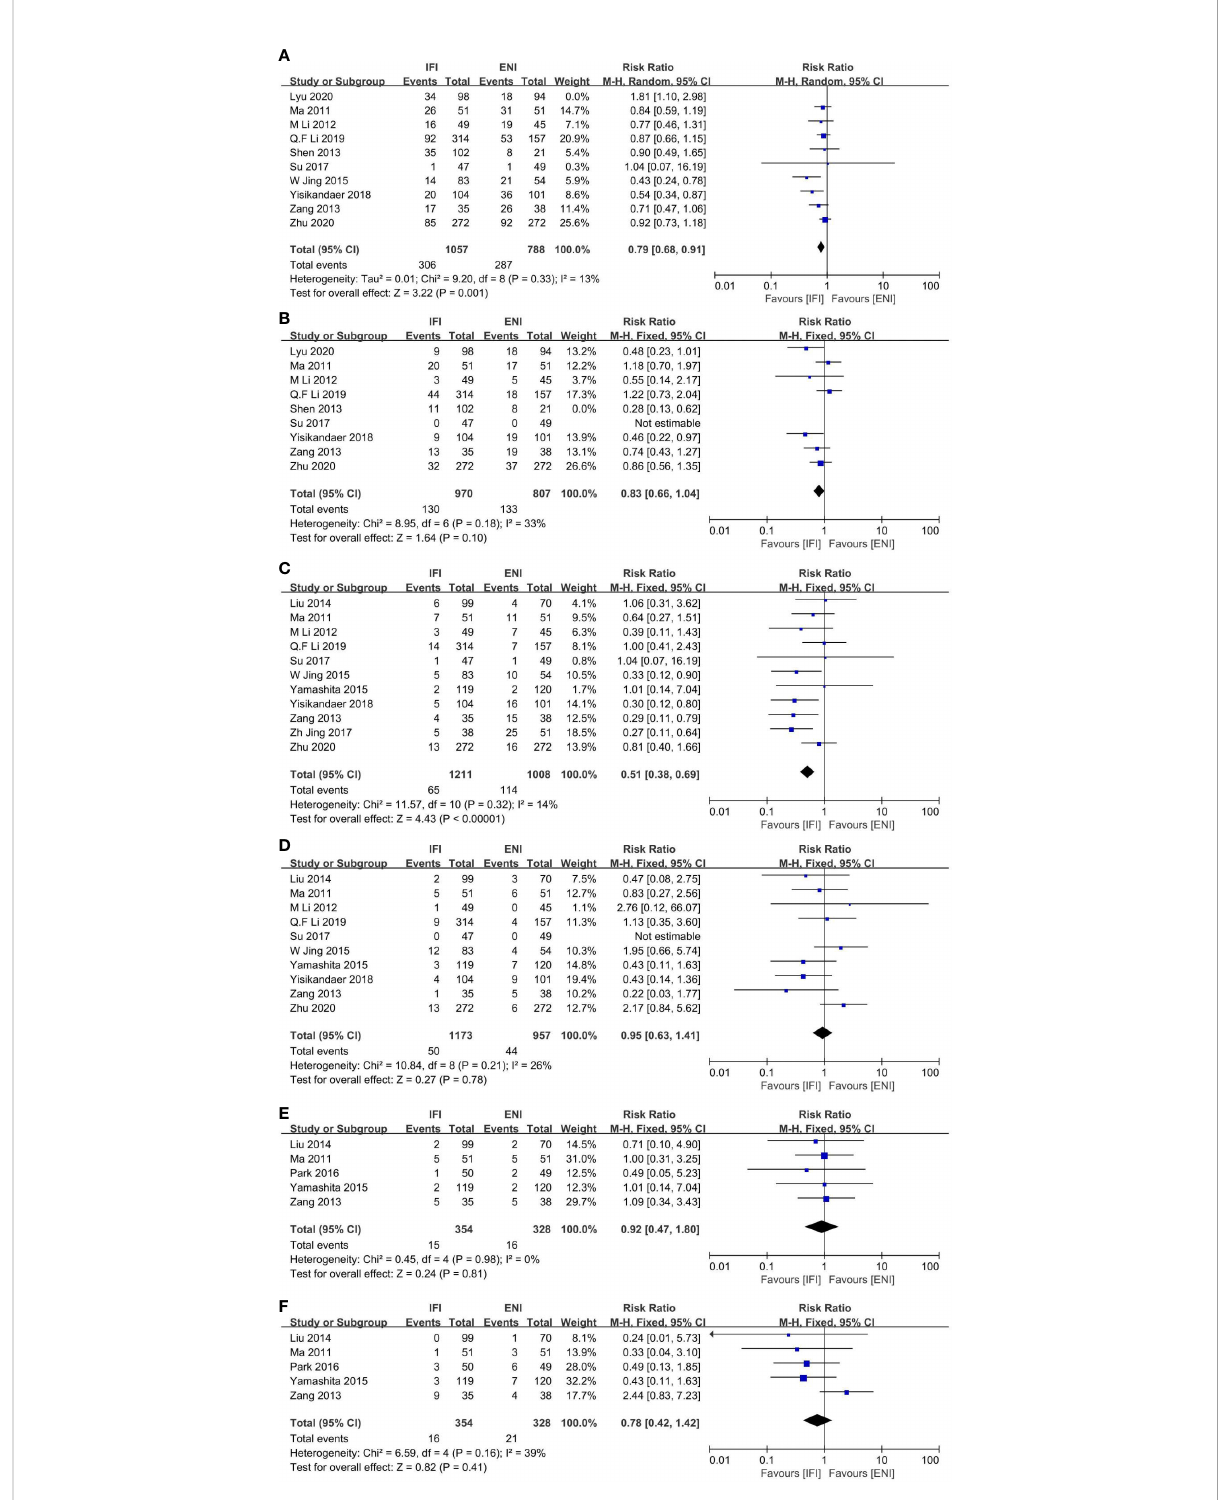
FIGURE 3 Forest plots of ≥ grade 2 acute esophagitis (A) , ≥ grade 2 acute pneumonitis (B) , ≥ grade 3 acute esophagitis (C) , grade 3 acute pneumonitis (D) , ≥ grade 3 late esophagitis (E) and ≥ grade 3 late pneumonitis (F) . IFI, involved fi eld irradiation; ENI, elective nodal irradiation; M-H, Mantel- Haenszel; CI, con fi dence